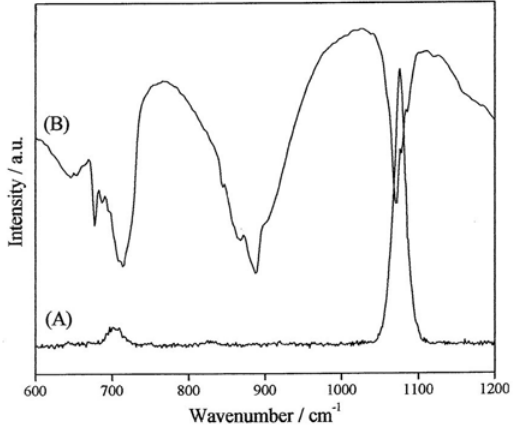
Fig. 3 – (a) Raman and (b) IR spectra of the calcium carbonate inorganic replica.